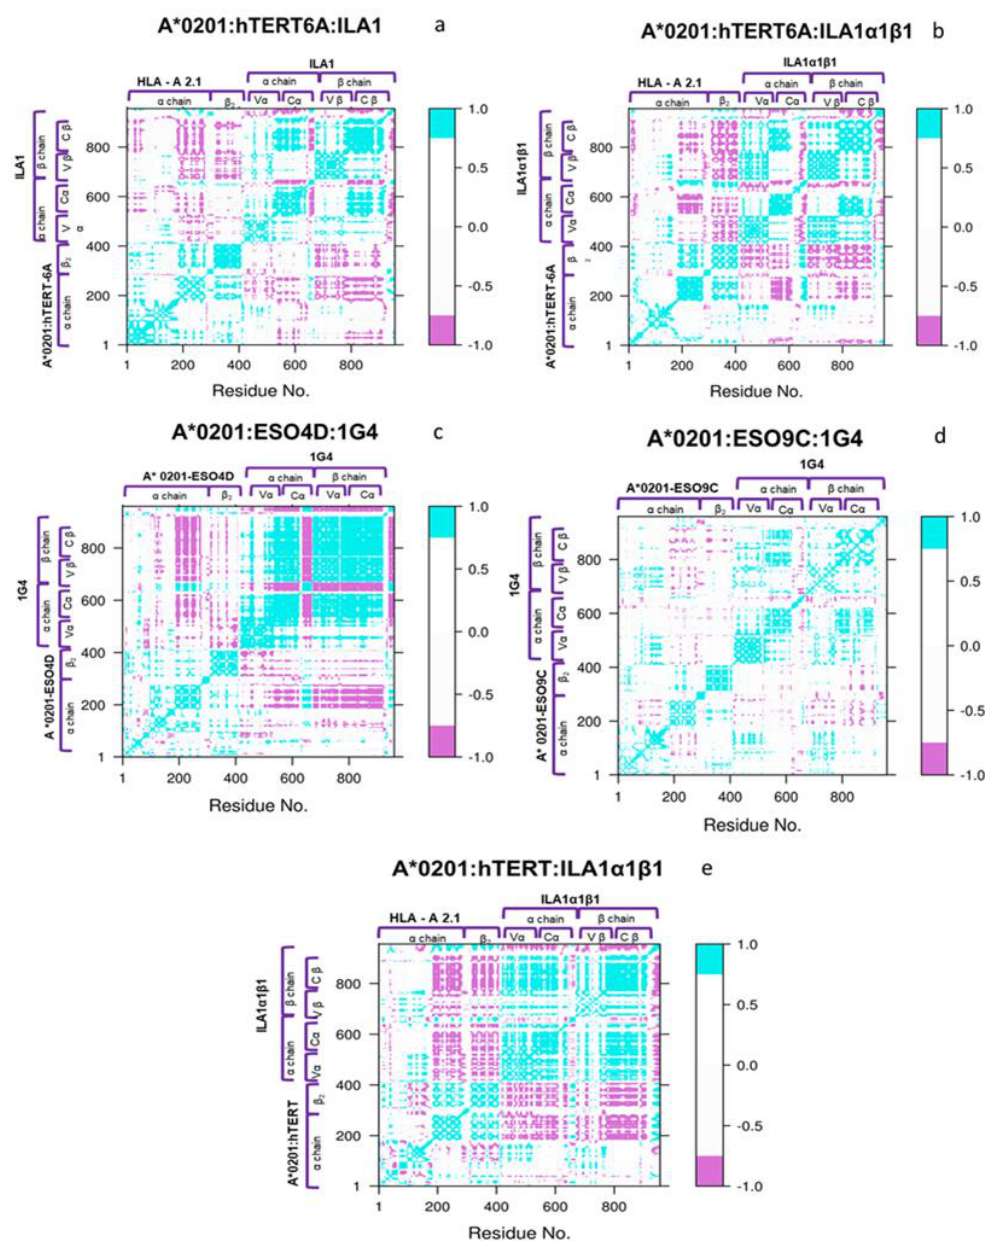
Figure 7. Cross correlation matrices. The correlation matrix of the whole complex pMHC-TCR is shown for the systems in study. The cyan regions indicate the presence of a correlation; the violet regions indicate an anti-correlation; the white regions show a non-correlation ( a – e.